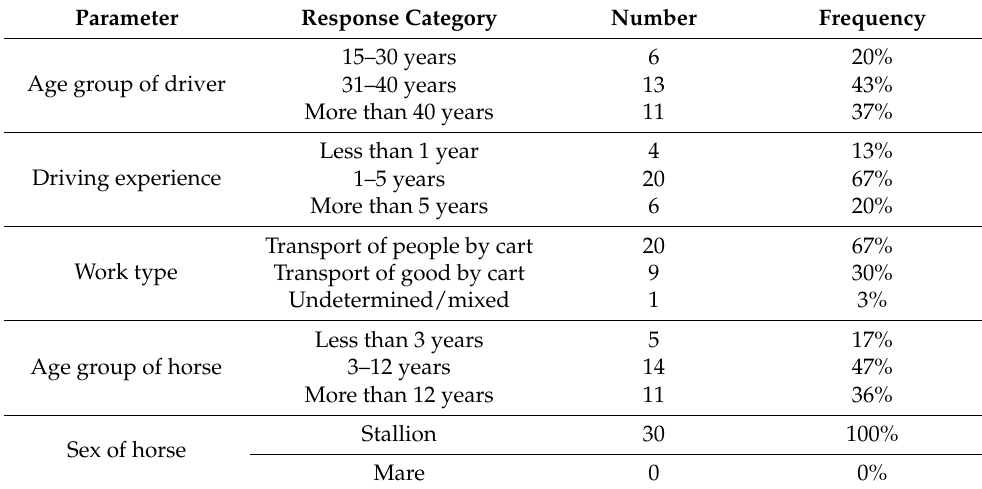
Table 3. Demographic information of owners and horses during the testing phase ( n =